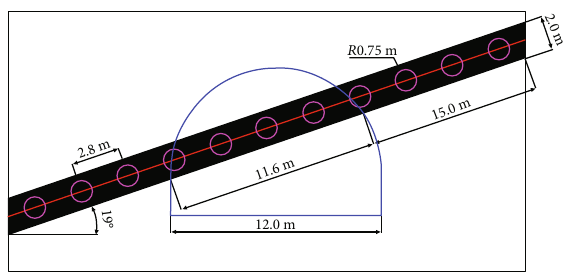
Figure 6: Schematic diagram of borehole arrangement for single- borehole extraction and hydraulic slotting extraction.